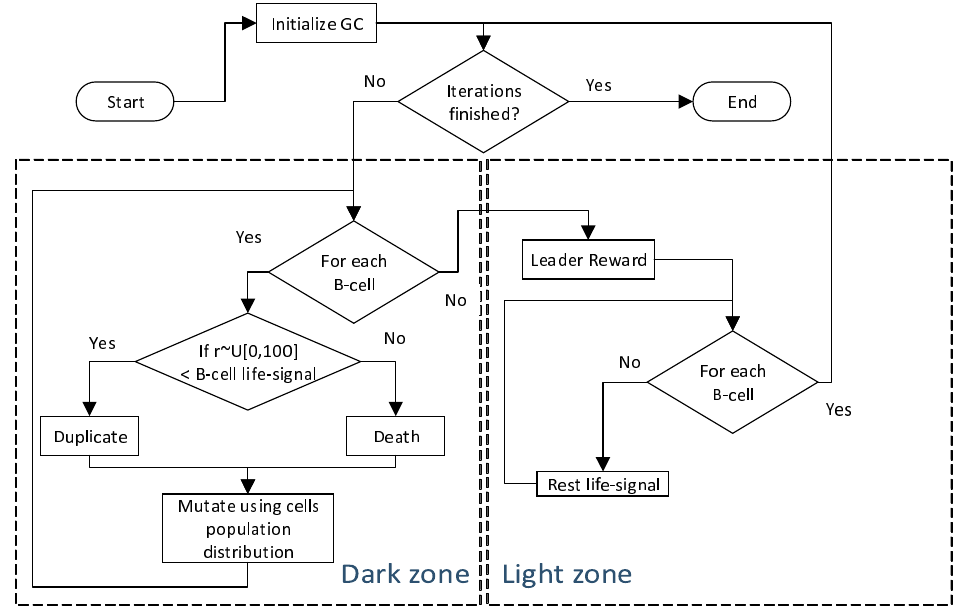
Figure 2. Germinal Center Optimization (GCO) algorithm